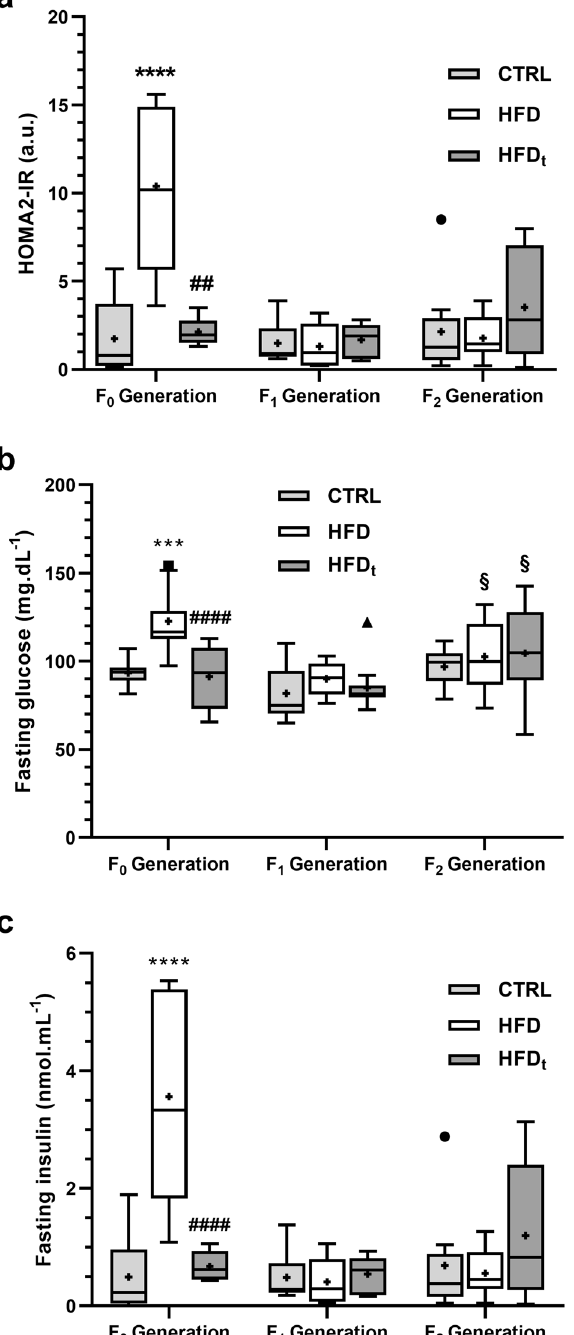
Figure 2. Glucose homeostasis across all the generations (n = 8 per group in each generation). ( a ) HOMA2-IR index; ( b ) fasting glycaemia; ( c ) serum insulin. Results are expressed as Tukey’s whisker boxes (median, 25th to 75th percentiles ± 1.5 interquartile range). Extreme values are represented individually according to the experimental group (filled circle CTRL—standard chow; filled square HFD—high-fat diet; filled triangle HFD t —transient high-fat diet). The samples were obtained in the day of sacrifice, 200 days post-weaning. Data was tested by one-way ANOVA with Tukey’s HSD for group comparison within the same generation. Two-way ANOVA with Šidak correction was used to compare each diet group in F 1 Generation against its F 2 counterparts. Graphs were obtained using the software GraphPad Prism 8 (San Diego, CA, USA). Significance was considered when p < 0.05. * vs. CTRL; # vs. HFD; § vs. F 1 Generation. Multiple significance signs represent different significance levels: *p < 0.05; **p < 0.01; ***p < 0.001; ****p < 0.0001. + Group